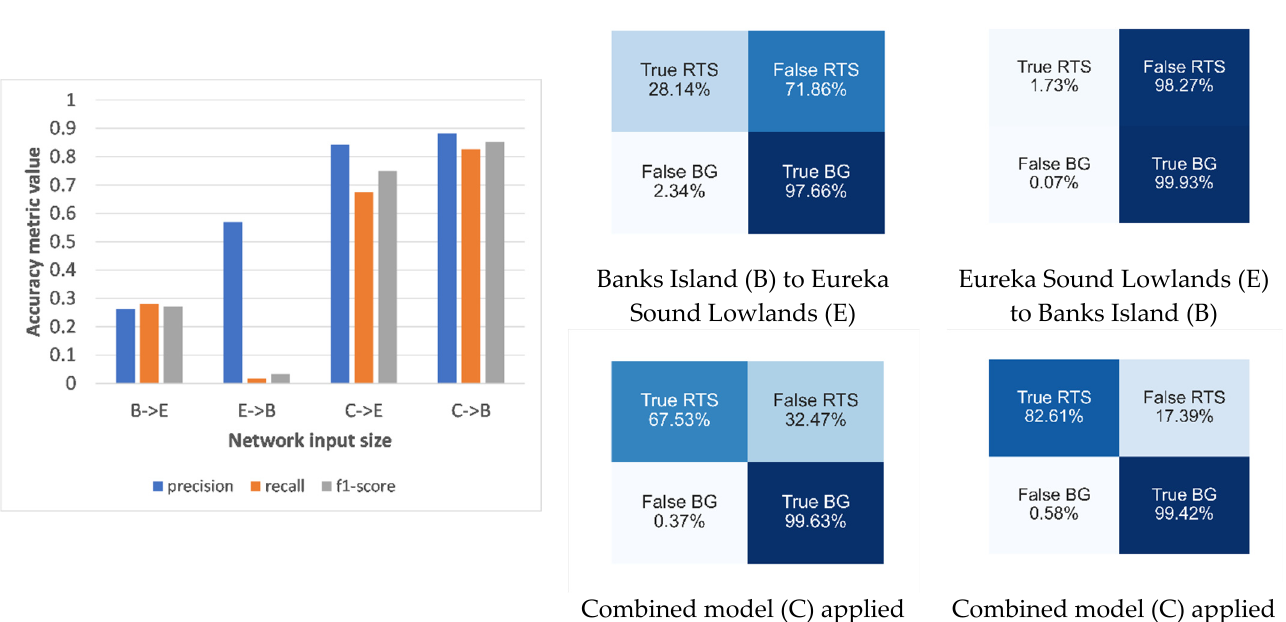
Figure 15. Effect of model transferability on the RTS prediction accuracy. Transferability scenarios considered include: (1) the DLCNN model trained on the RTS data from Banks Island (B) and applied to test data from Eureka Sound Lowlands (E), (2) the DLCNN model trained on the RTS data from Ellesmere Island (E) and applied to test data from Banks Island (B), (3) the DLCNN model trained on the combined RTS data and applied to Eureka Sound Lowlands (E), and (4) the DLCNN model trained on the combined RTS data and applied to Banks Island (B). Bar charts depict accuracy measures of Precision, recall, and F1 score. Corresponding confusion matrix for each of the scenarios shown on the right.